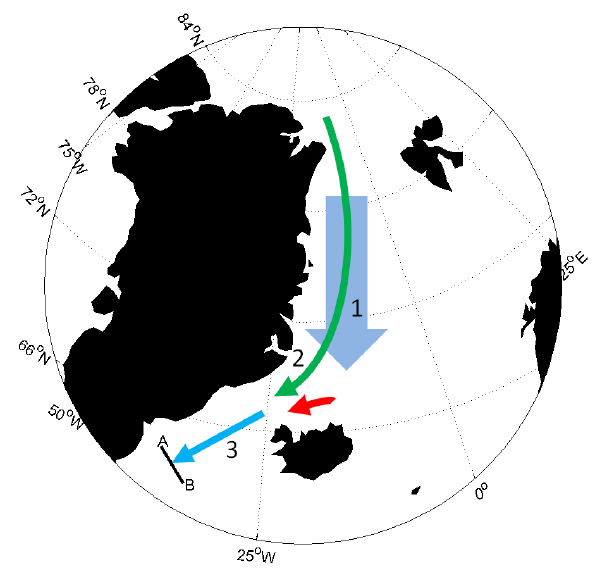
Fig. 16. The suggested mechanism controlling salinity anomalies at the Angmagssalik moorings (Section AB). 1. Southward wind stress increases. 2. Increase in volume flux of fresh intermediate EGC water arriving at the sill. 3. Freshening of Denmark Strait Overflow Water. Total time for whole process is 4 ½ months.